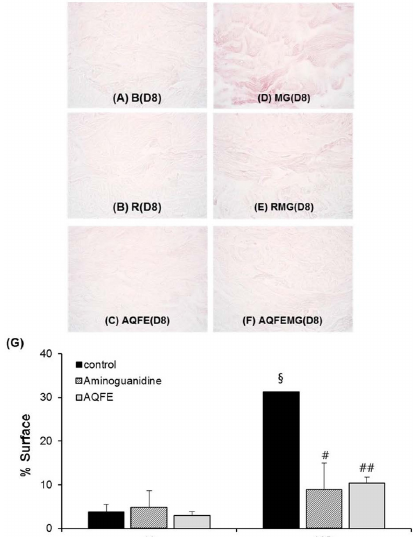
Figure 3. Activity of AQFE against methylglyoxal ‐ induced glycation, revealed by the immunostaining of CML. The explants were kept alive in a BEM culture medium for eight days with the vehicle and 1% AQFE. CML immunostaining was conducted. Immunostaining of CML on untreated batch ( A ); treated with AG ( B ); treated with AQFE ( C ); treated with MG ( D ); treated with MG + AG ( E ) and treated with MG + AQFE ( F ). ( G ) Staining intensity on batches treated with active ingredients on CML immunostaining. The average staining intensity values were calculated using Image J software. Data are mean ± standard deviation. § p < 0.01 compared with the vehicle ‐ treated group; # p < 0.05 compared with the MG-treated group; ## p < 0.01 compared with the MG-treated group ( n = 3). The results were confirmed by eight independent experiments.